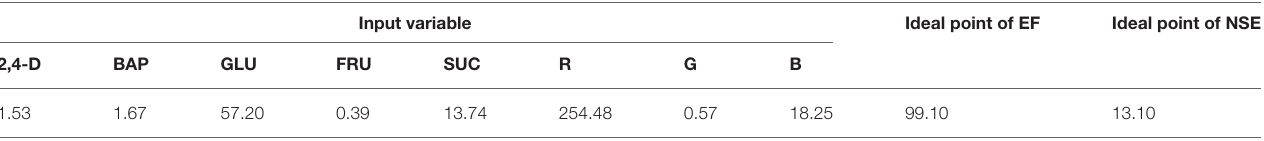
TABLE 3 | Optimizing growth factors according to optimization analysis on the developed ANFIS-NSGAII in the ideal point for embryogenesis frequency (EF) and number of somatic embryo (NSE) in chrysanthemum.